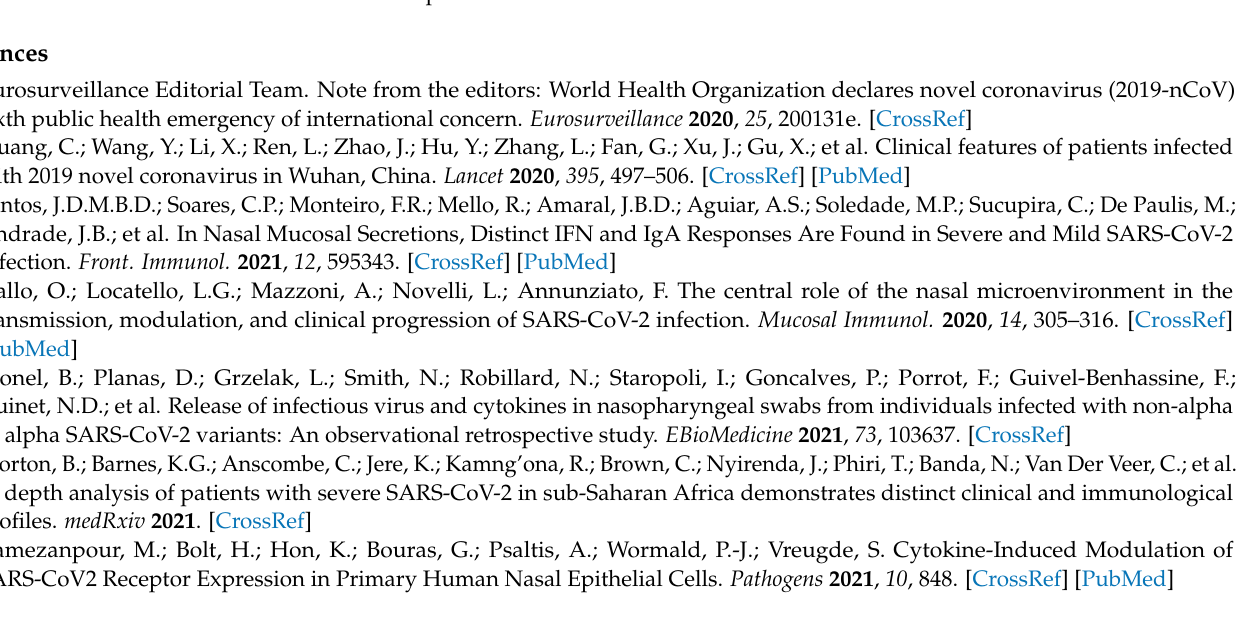
profiles, Figure S3: Canonical pathways significantly enriched in nasal explant culture supernatants in comparison to plasma, Figure S4: Relative cytokine expression in the nasal compartment to plasma, Figure S5: Canonical pathways significantly enriched in oral explant culture supernatants in comparison to nasal tissue, Figure S6: Correlogram of responses elicited systemically, Figure S7: Correlogram of responses elicited in nasal explants, Table S1: List of differentially expressed proteins in nasal explant culture supernatants and plasma, Table S2: List of differentially expressed proteins in nasopharyngeal (NP) swabs and plasma, Table S3: List of differentially expressed proteins in nasal explant culture supernatants and plasma, Table S4: List of differentially expressed proteins in nasal and oral explant culture